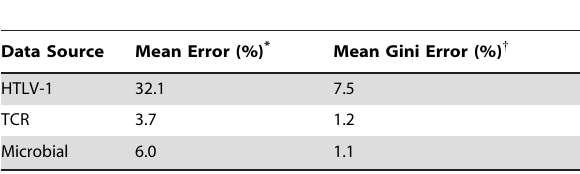
Table 2. Performance of DivE frequency distribution generation